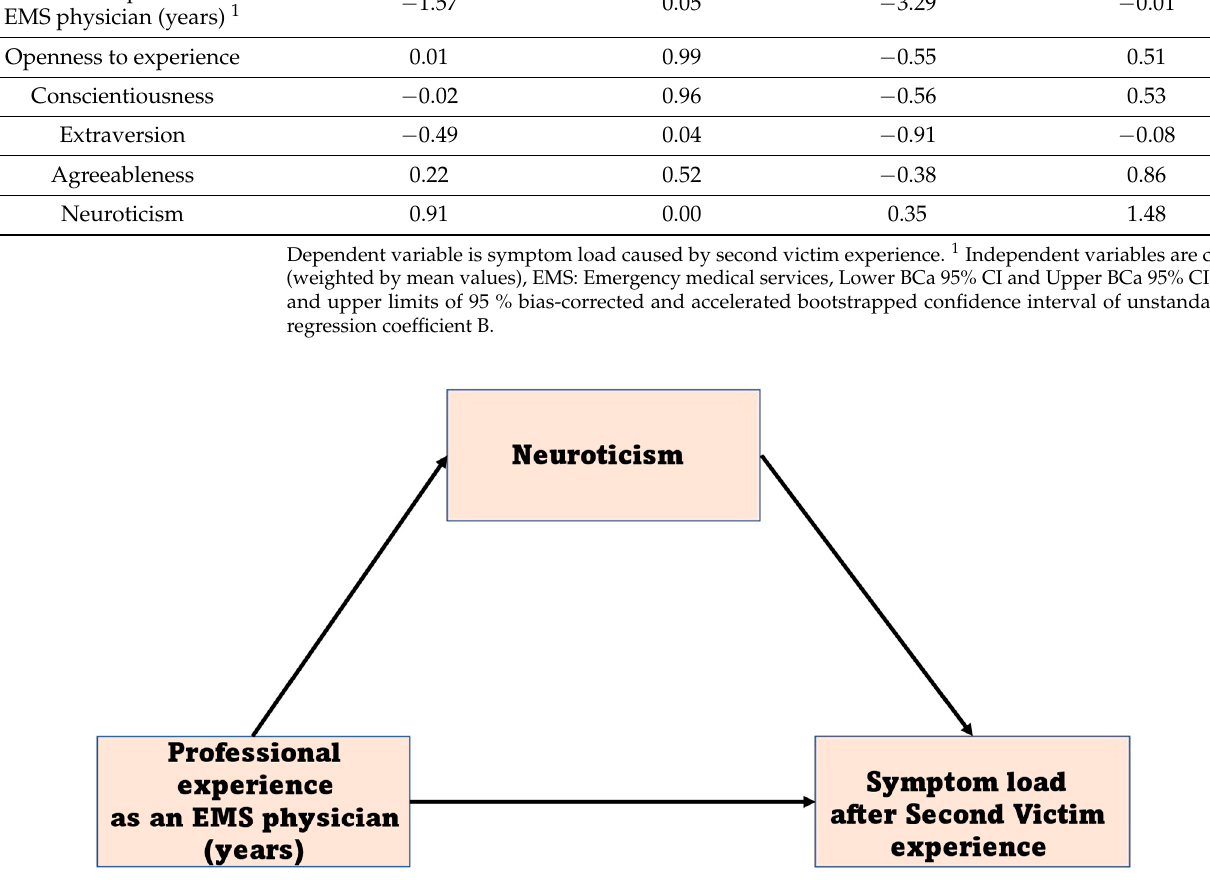
Figure 1. Mediation model. EMS: Emergency medical services, Neuroticism: One out of Big Five Personality Traits, Symptom load: the sum of symptoms after second victim